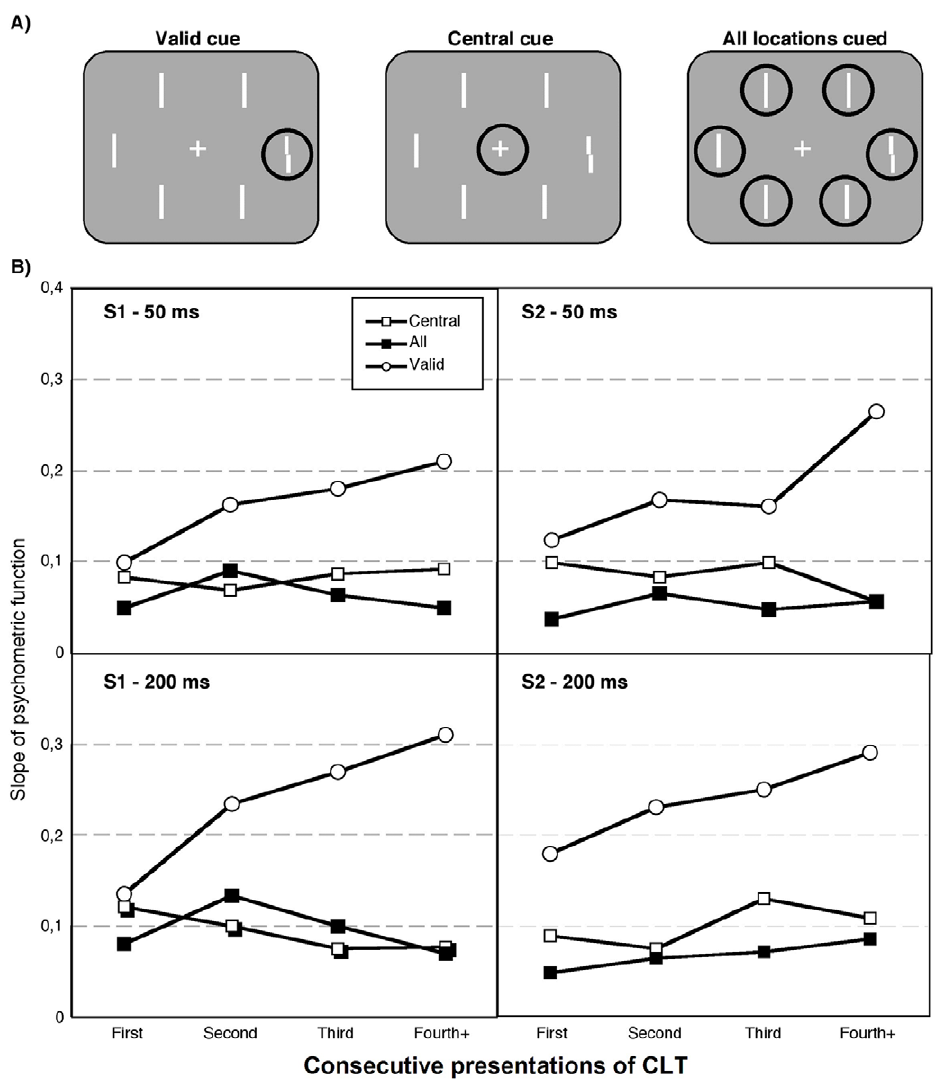
Figure 3. The three different cue types used in experiment 2 along with results. Panel A shows the three cue types used in experiment 2. The slopes of the psychometric functions (see methods for experiment 1) are shown in panel B for the two naı¨ve observers (S1 and S2) for the two different CLTs as a function of trial-by-trial repetitions of CLT. The lines show linear fits to the data for the respective conditions. All the slopes for the valid cue increased significantly with CLT repetition as assessed with bootstrapped confidence intervals, but this was not the case for the ‘‘all’’ and ‘‘central’’ cue conditions.